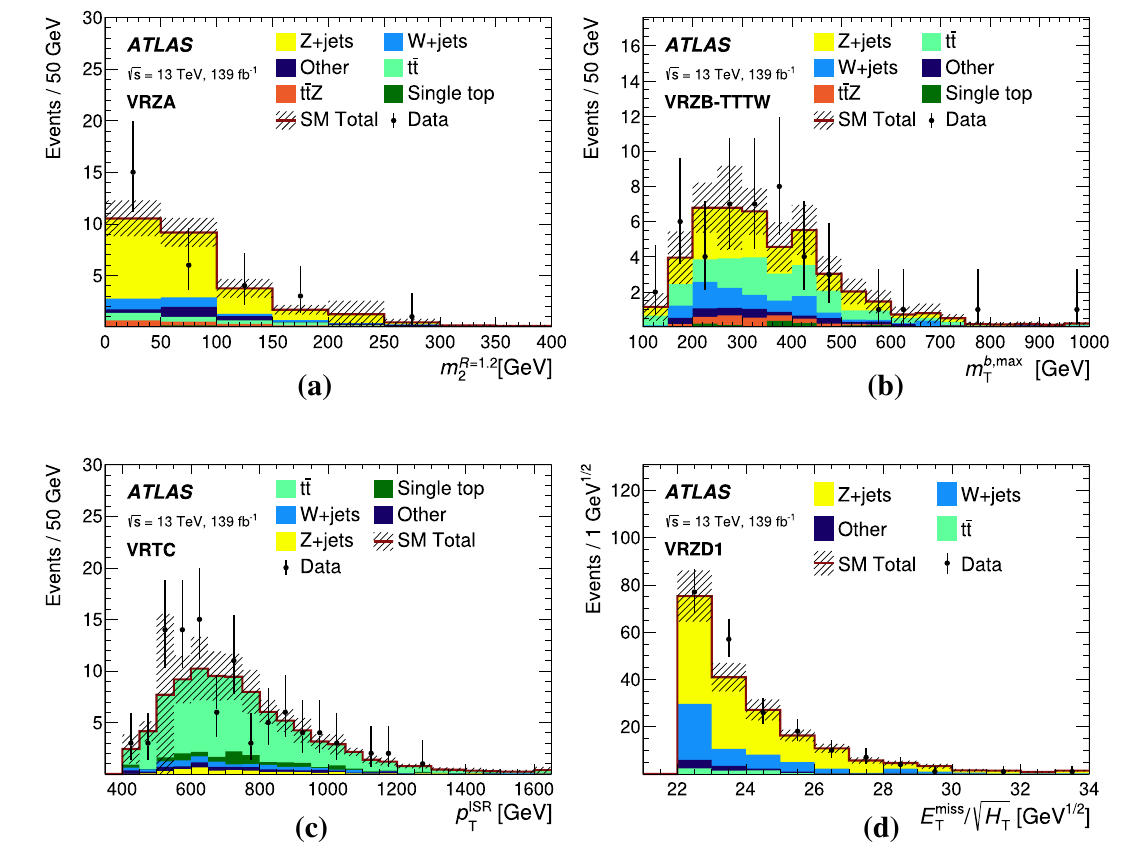
√ / Fig. 9 Distributions illustrating the level of agreement between data H T in VRZD1. The hatched uncertainty band around the SM E miss T (points) and the SM expectation (stacked histograms, after simulta- expectation includes the combination of MC statistical, theory-related neously fitting to all backgrounds) in several validation regions: a and detector-related systematic uncertainties. The rightmost bin in each plot includes all m R = 1 . 2 in VRZA, b m b , min in VRZB-TTTW, c p ISR in VRTC, and d T T 2